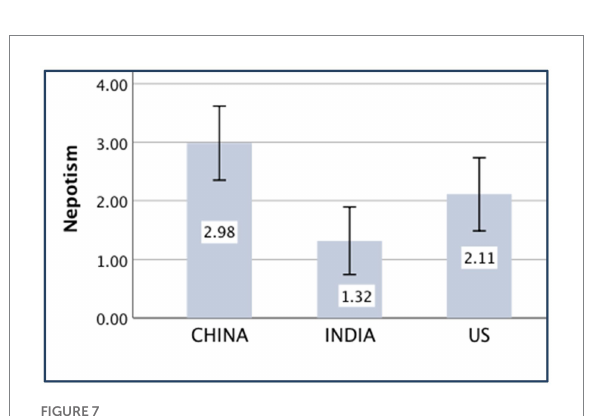
FIGURE 7 Nepotism of China, India, and the United States